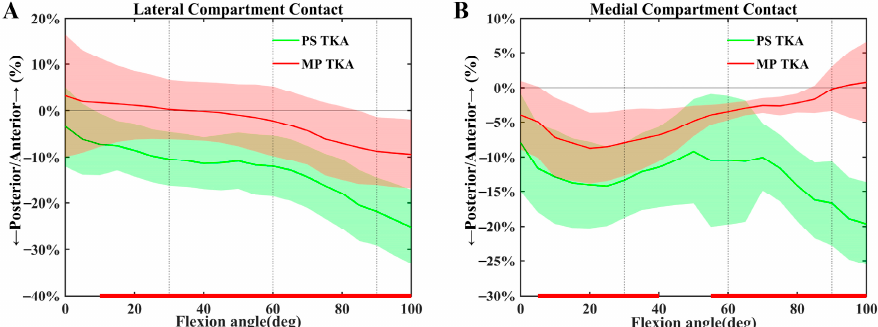
Figure 4. The average articular contact points in PS-TKA and MP-TKA knees were displayed through the range of flexion on lateral ( A ) and medial ( B ) compartments. Colored areas represent standard deviations. The red bars along the horizontal axis indicated statistically significant differences range ( p < 0.0500). MP: Medial-pivot. PS: Posterior-stabilized. TKA: Total knee arthroplasty. Table 3. Average and standard deviation of medial and lateral contact locations of MP and PS TKA at 0°, 30°, 60°, 90° and 100° of lunge flexion along the anterior/posterior and lateral/medial direction were shown.